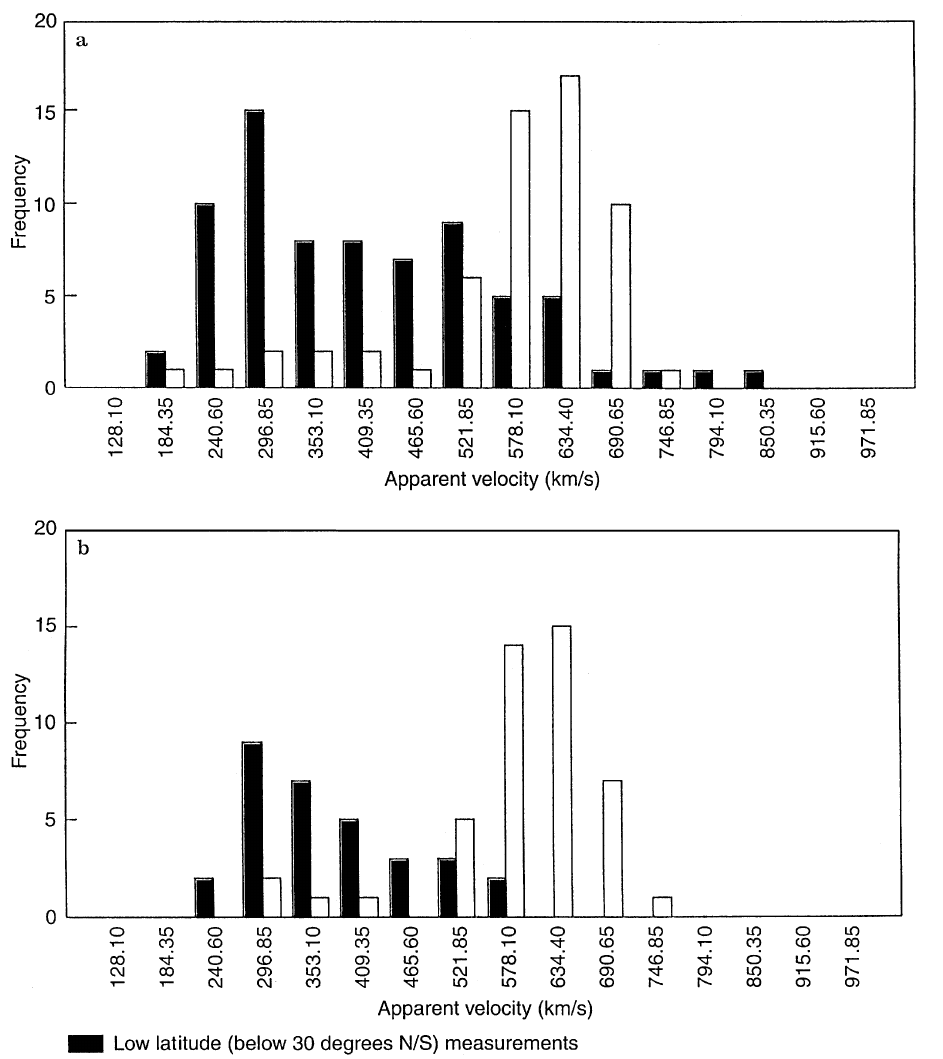
Fig. 4a,b. Histograms of apparent solar wind velocity measurements for high ( ’ 60 (cid:48) N/S) and low ( ( 30 (cid:48) N/S) heliographic latitudes, 1992 — 1995. a All measurements; b all cases where one velocity